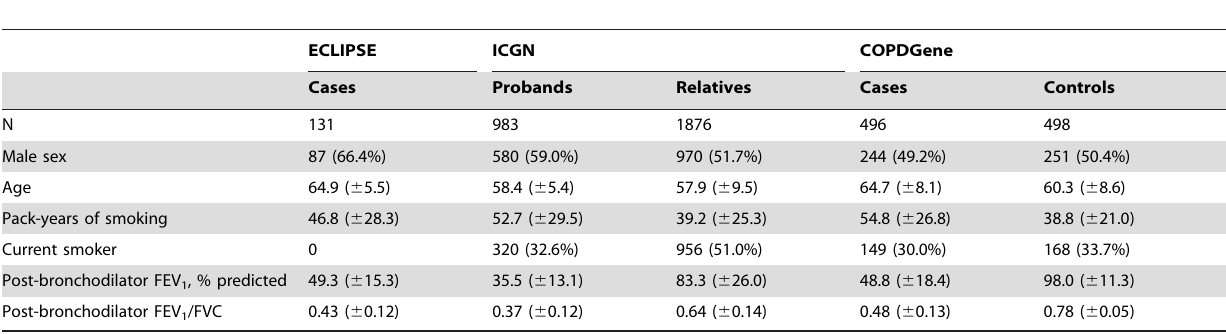
Table 1. Characteristics of Evaluation of COPD Longitudinally to Identify Predictive Surrogate End-points (ECLIPSE) study subjects in the integrative genomics analysis as well as subjects from the International COPD Genetics Network (ICGN) and the Genetic Epidemiology of COPD study (COPDGene) included in follow-up